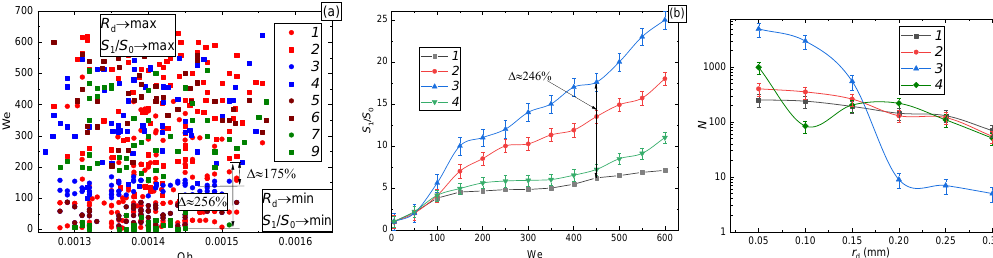
Figure 5. (a) Regime map of the drop impact on the wall (circle — deposition of the first drop and Figure 5. ( a ) Regime map of the drop impact on the wall (circle—deposition of the first drop and coalescence with all others, square — breakup) as a function of We(Oh): 1,2 — T ≈ 20 °C; 3,4 — T ≈ 50 °C; coalescence with all others, square—breakup) as a function of We(Oh): 1,2 — T ≈ 20 ◦ C; 3,4 — T ≈ 50 ◦ C; 5,6 — T ≈ 100 °C; 7,8 — T ≈ 180 °C; (b) S 1 / S 0 (We); (c) size distribution of child droplets at We = 200 and at 5,6 — T ≈ 100 ◦ C; 7,8 — T ≈ 180 ◦ C; ( b ) S 1 / S 0 (We); ( c ) size distribution of child droplets at We = 200 and different wall temperatures: 1 — T ≈ 20 °C; 2 — T ≈ 50 °C; 3 — T ≈ 100 °C; 4 — T ≈ 180 °C. at di ff erent wall temperatures: 1 — T ≈ 20 ◦ C; 2 — T ≈ 50 ◦ C; 3 — T ≈ 100 ◦ C; 4 — T ≈ 180 ◦ C.